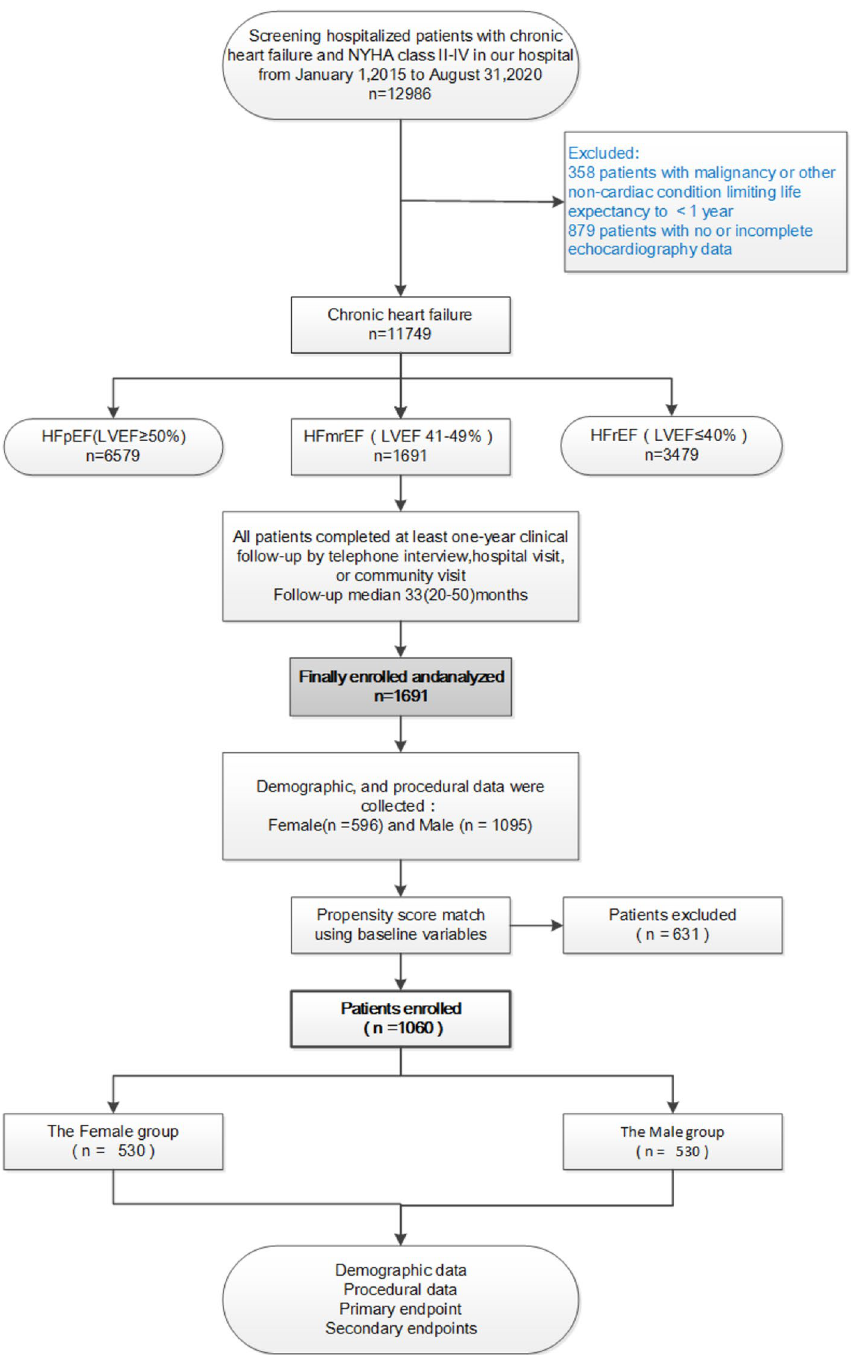
Figure 1. Flow diagram for participant screening, eligibility and